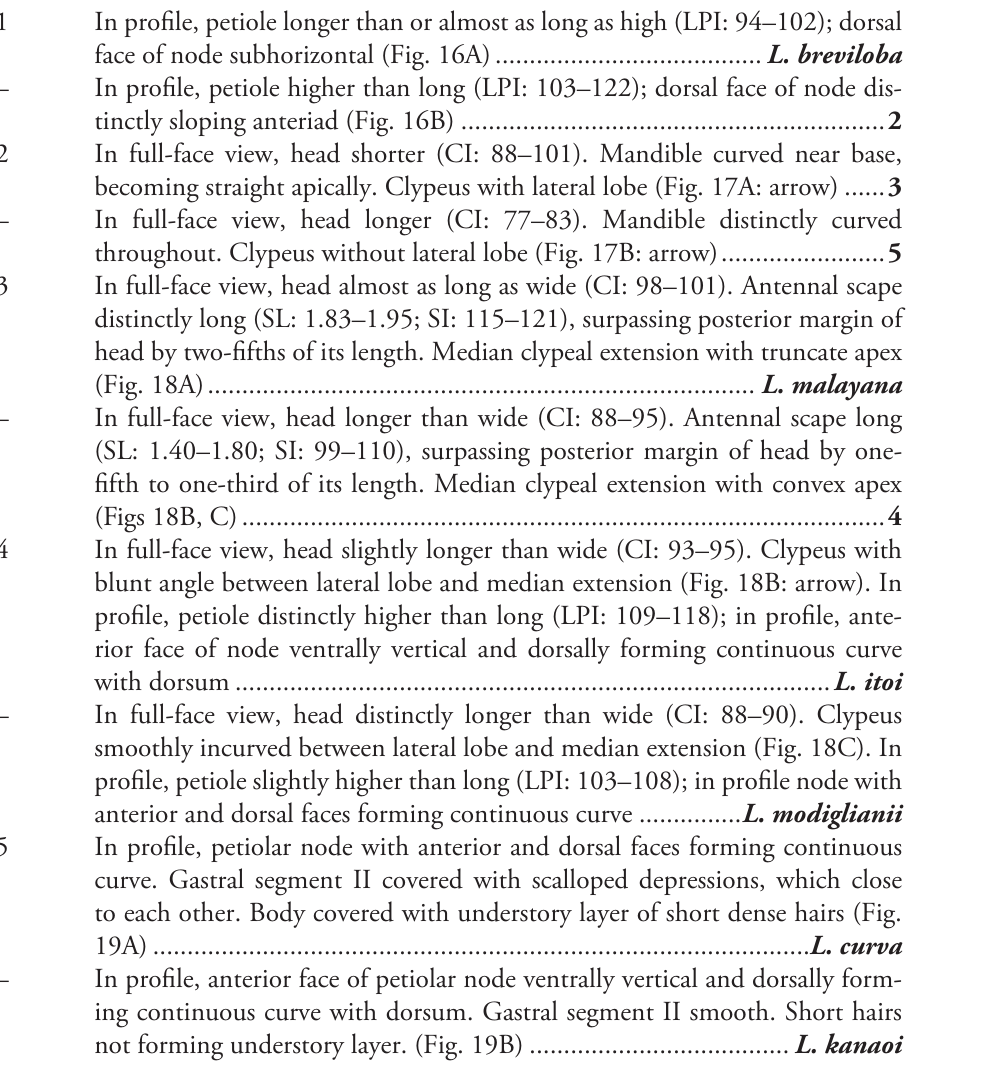
throughout. Clypeus without lateral lobe (Fig. 17B: arrow) ........................ 5 In full-face view, head almost as long as wide (CI: 98–101). Antennal scape distinctly long (SL: 1.83–1.95; SI: 115–121), surpassing posterior margin of head by two-fifths of its length. Median clypeal extension with truncate apex (Fig. 18A) ................................................................................ L. malayana In full-face view, head longer than wide (CI: 88–95). Antennal scape long (SL: 1.40–1.80; SI: 99–110), surpassing posterior margin of head by one- fifth to one-third of its length. Median clypeal extension with convex apex (Figs 18B, C) .............................................................................................. 4 4 In full-face view, head slightly longer than wide (CI: 93–95). Clypeus with blunt angle between lateral lobe and median extension (Fig. 18B: arrow). In profile, petiole distinctly higher than long (LPI: 109–118); in profile, ante- rior face of node ventrally vertical and dorsally forming continuous curve with dorsum ....................................................................................... L. itoi – In full-face view, head distinctly longer than wide (CI: 88–90). Clypeus smoothly incurved between lateral lobe and median extension (Fig. 18C). In profile, petiole slightly higher than long (LPI: 103–108); in profile node with anterior and dorsal faces forming continuous curve ............... L. modiglianii 5 In profile, petiolar node with anterior and dorsal faces forming continuous curve. Gastral segment II covered with scalloped depressions, which close to each other. Body covered with understory layer of short dense hairs (Fig. 19A) ................................................................................................ L. curva – In profile, anterior face of petiolar node ventrally vertical and dorsally form- ing continuous curve with dorsum. Gastral segment II smooth. Short hairs not forming understory layer. (Fig. 19B) ...................................... L.